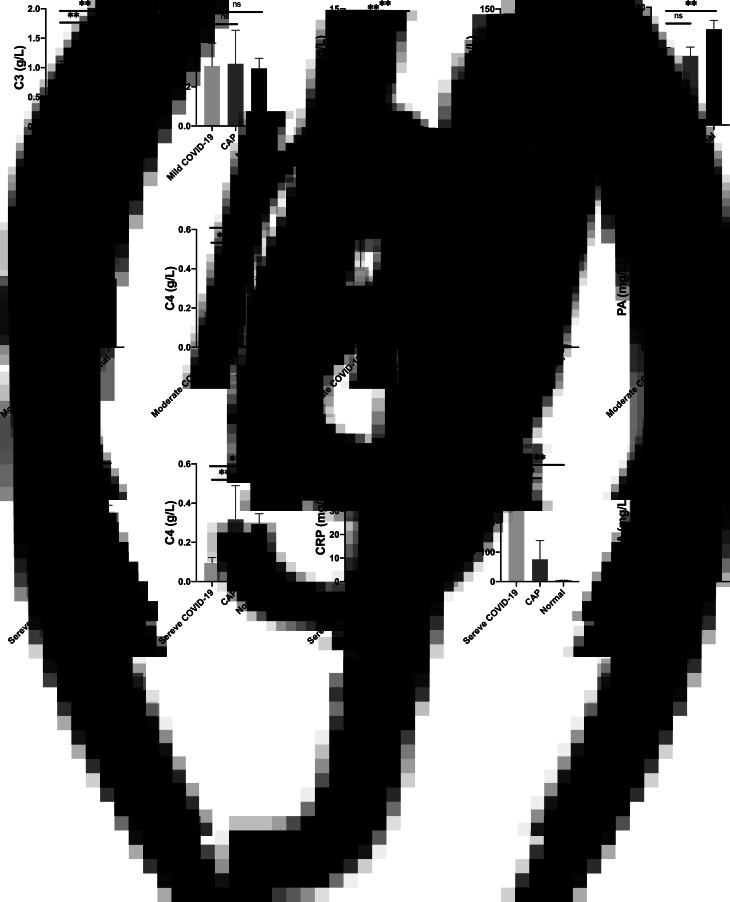
Different APRP contents in mild, moderate and severe cases of COVID-19, CAP patients and the normal control group (ns P > 0.05, ** P < 0.01).